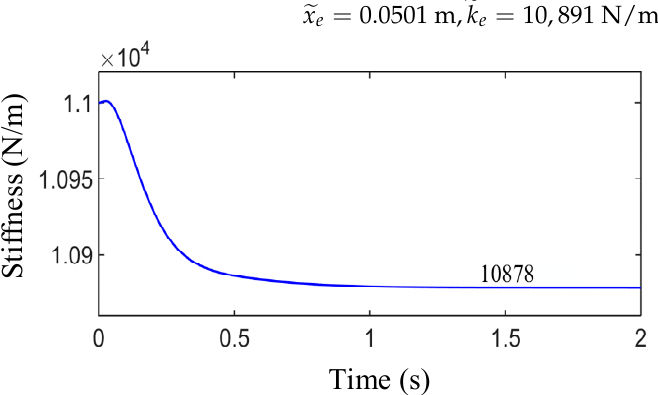
Figure 15. Simulation diagram of environmental stiffness estimation.